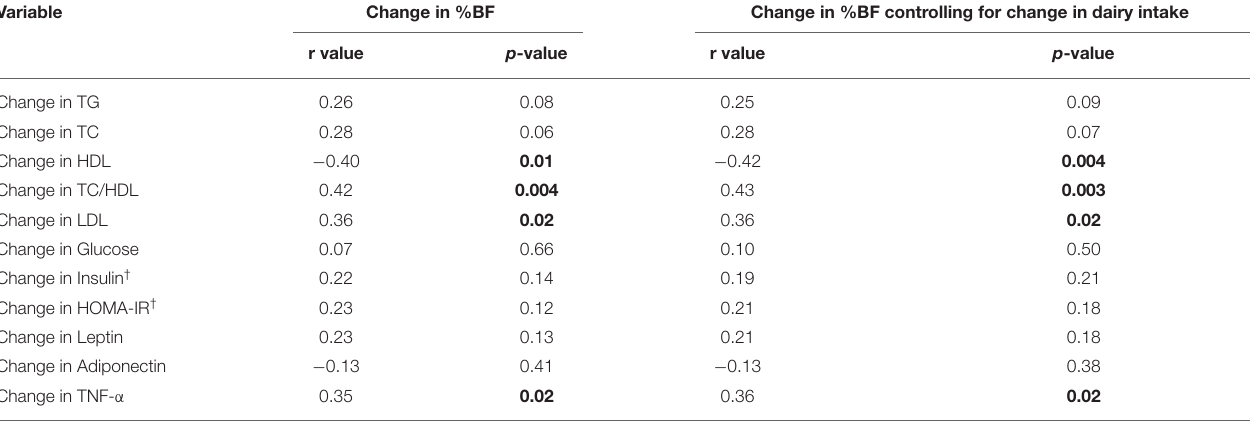
TABLE 4 | Group aggregated ( n = 46) partial correlations on change in percent body fat and cardiometabolic variables with and without change in dairy product servings as a control variable.